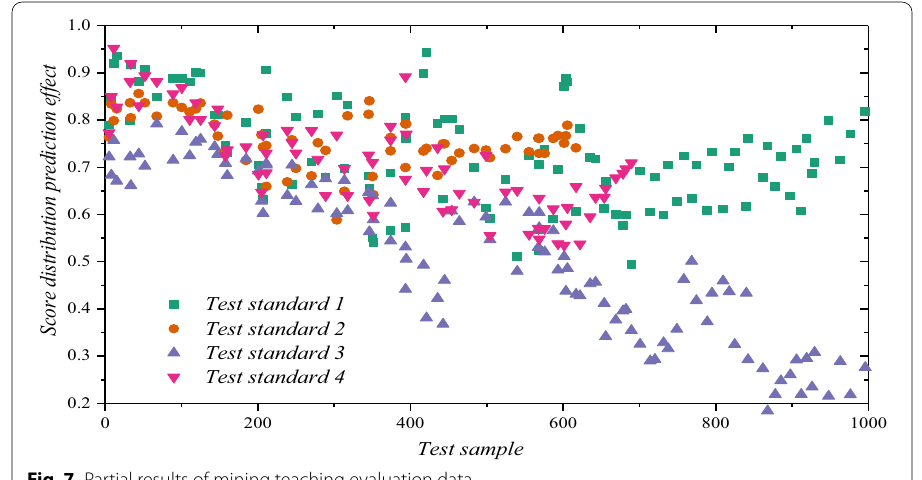
Fig. 7 Partial results of mining teaching evaluation